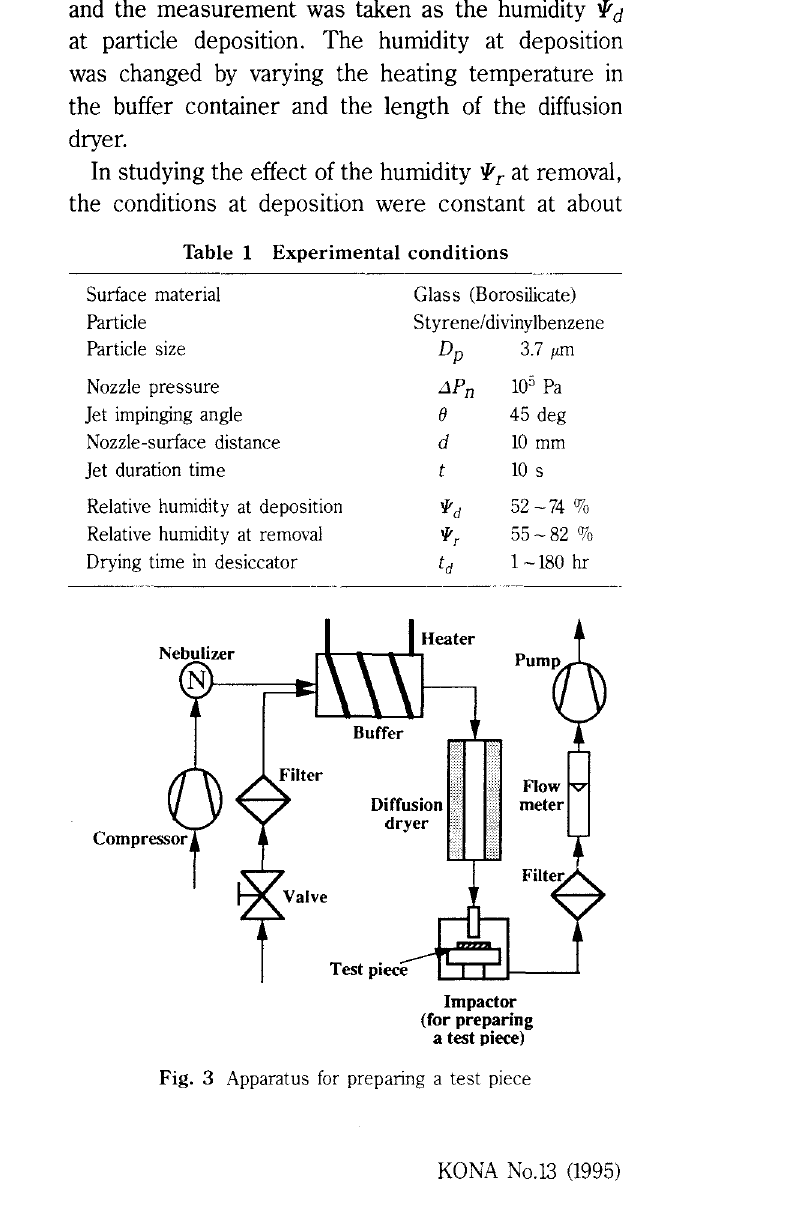
Fig. 1 Schematic diagram of experimental apparatus